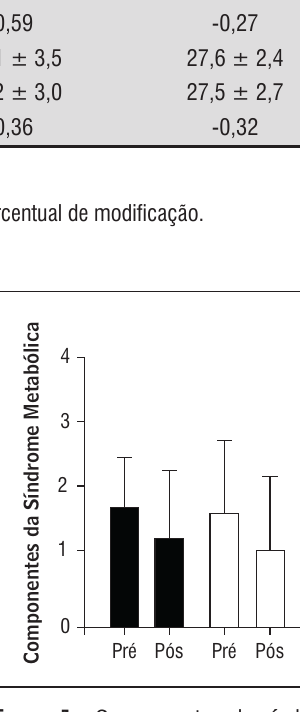
Figura 1 - Componentes da síndrome metabólica Pré e Pós 16 semanas de treinamento aeróbio (TA), de